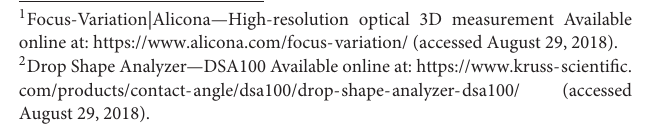
TABLE 1 | Characteristics of industrial synthetic graphite grades, given by the supplier. Electric resistivity ( µ (cid:127)